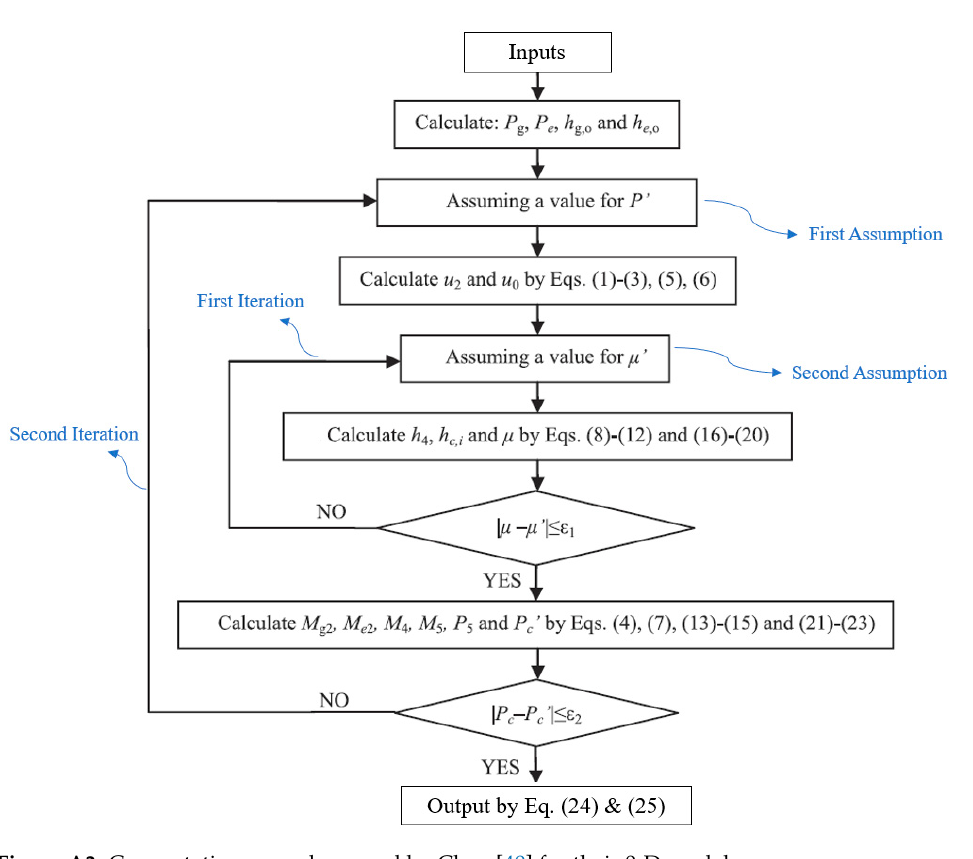
Table A3. Comparison of the results of developed EES model and results reported by Huang et al. [34] and Chen [40] . P g